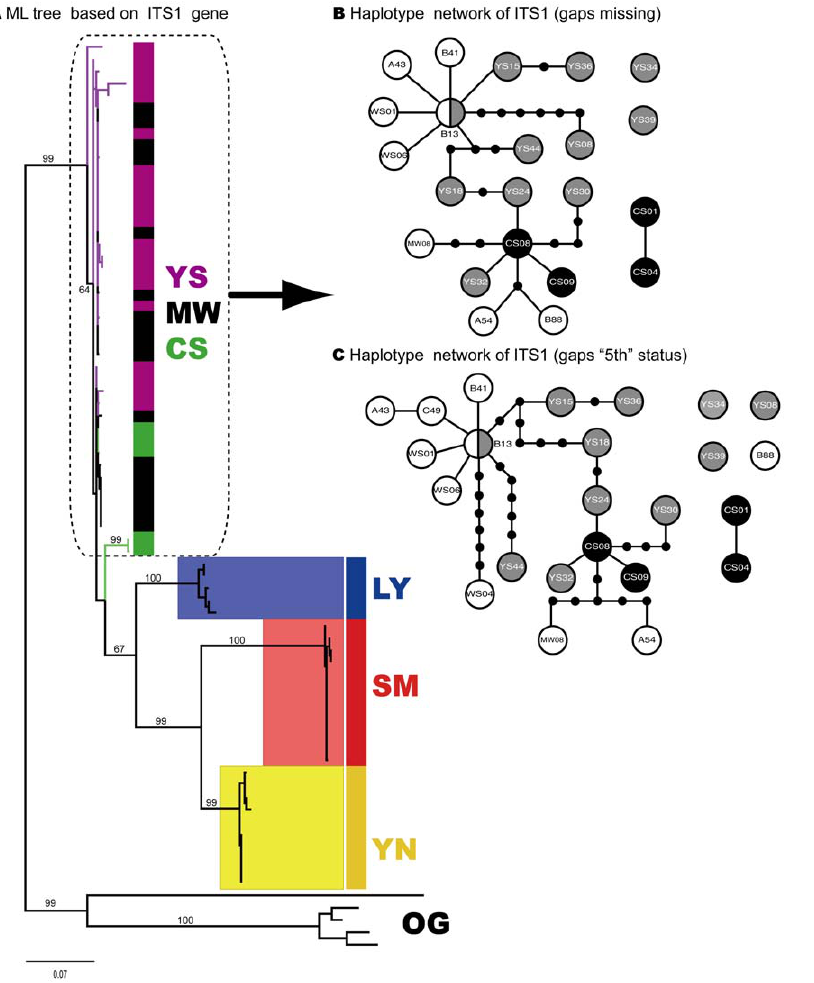
Figure 3. Phylogenetic trees (ML) of six Dendrolimus pine moth species constructed with single COI gene and Haplotype network for three mostly closely related species D.punctatus , D.tabulaeformis , D.spectabilis . a) ML tree based on ITS1 gene; Clades with different colors indicate different species respectively. MW - D. punctatus , SM - D. kikuchii , YN - D. houi , YS - D. tabulaeformis , CS - D. spectabilis , LY - D. superans ; OG - OUTGROUP; Numbers above branches indicate bootstrap values (less than 50 not shown) (hereinafter). Clades with light blue branches indicate GMYC species, see text for details; b) Haplotype network of ITS1 gene (gaps missing); c) Haplotype network of ITS1 gene (gaps ‘‘5th’’ status). Empty circles mean haplotypes of species D. punctatus , gray circles indicate haplotypes of species D. tabulaeformis , and black circles represent haplotypes of species D. spectabilis .